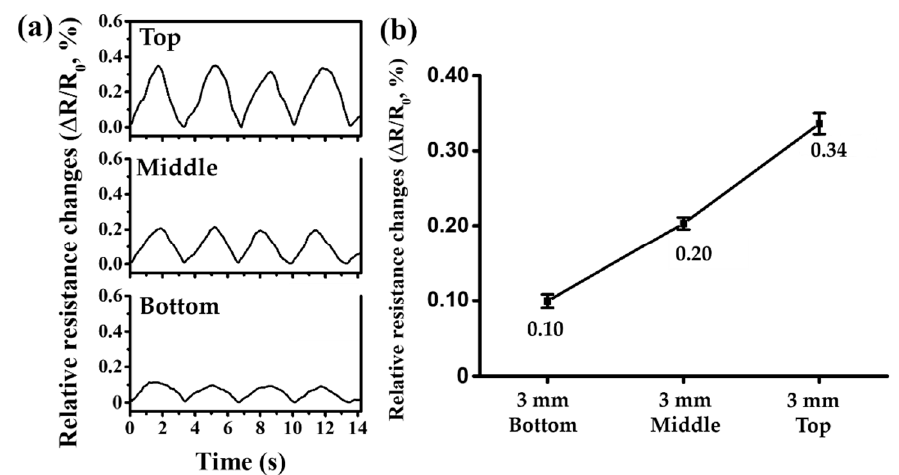
Figure 8. Experimental results of the relative electrical resistance changes in the vessels of 3 mm diameter: ( a ) changes in relative electrical resistances at the Top, Middle, and Bottom positions; ( b ) graph of mean relative changes in electrical resistances at the Top, Middle, and Bottom positions.